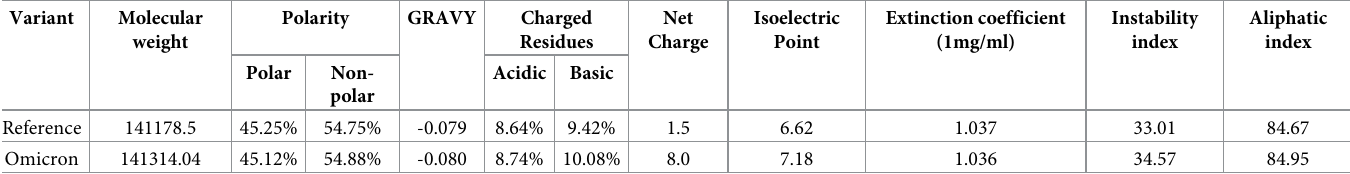
Table 1. Differences in the physicochemical properties of reference and Omicron variant spike